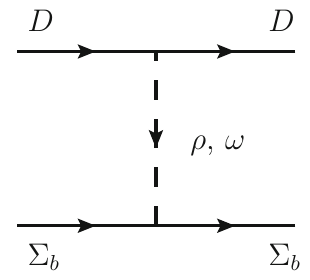
Fig. 1 Example of interaction for one of the channels